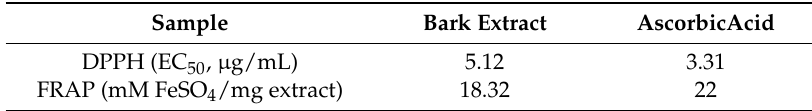
Table 2. Antioxidant properties of a methanol extract from T. fischeri bark. Sample